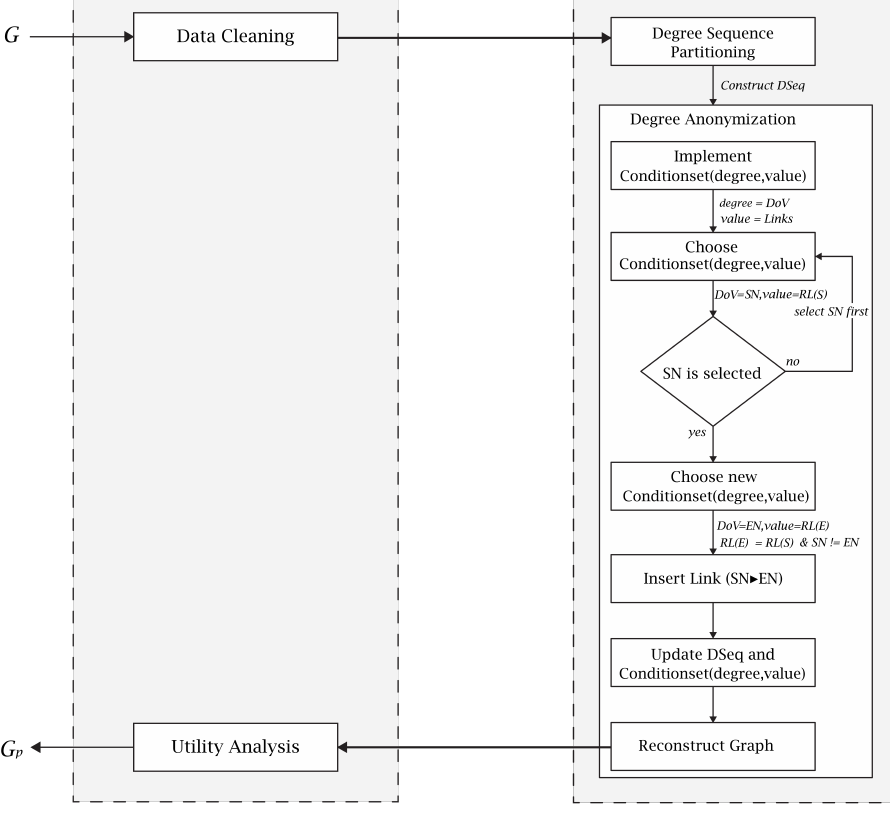
Figure 6. Overview of proposed k -NDDP